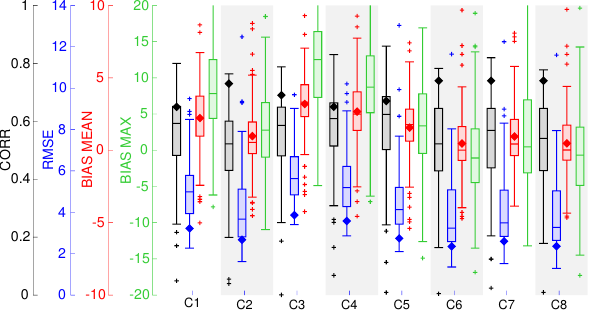
Figure 5. Different performance metrics for the comparison of ob- servations and simulation results for storm Lothar. Each column represents the results of one sensitivity simulation in Table 2. The temporal performance is illustrated by boxplots which represent the distribution of four metrics over 109 weather stations: correla- tion (black), RMSE (blue), model–observation mean bias (red) and model–observation maximum bias (green). Four different scales are employed, which match the different colours of the symbols. The diamonds represent the spatial performance. They are calculated for the mean wind speed of each location. The boxes represent the second and third quartiles, whereas the whiskers extend from the ends of the box to the most distant point whose y value lies within 1.5 times the interquartile range. Outliers are depicted by